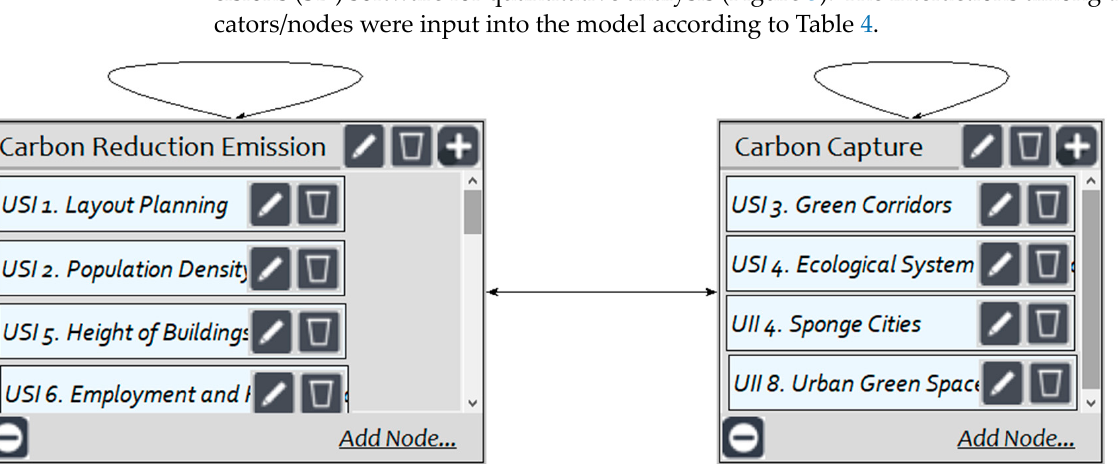
Figure 5. Structural model of the CER cluster and CC cluster based on the ANP.